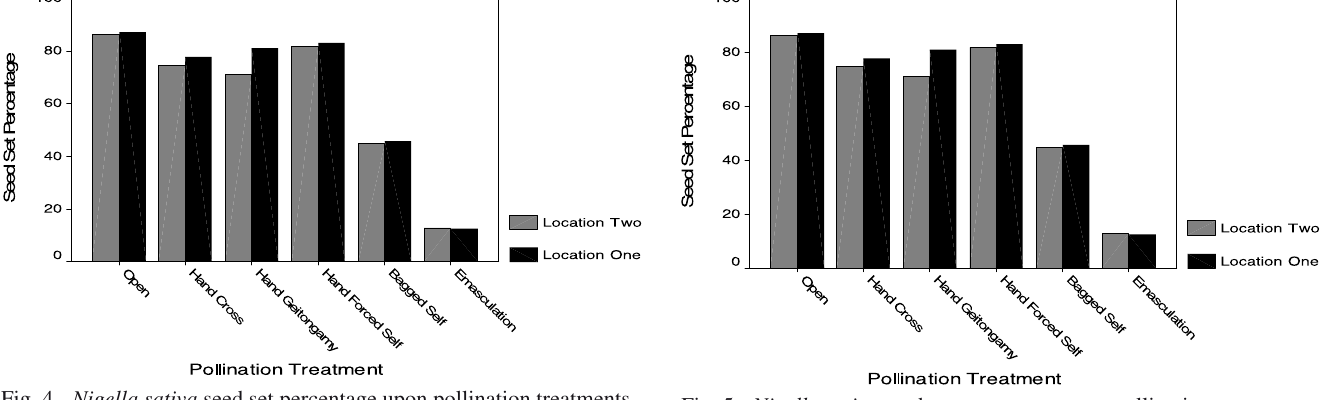
Table 4 - Seeds set after different pollination treatments in Nigella sativa location B. Season two Treatment of pollination